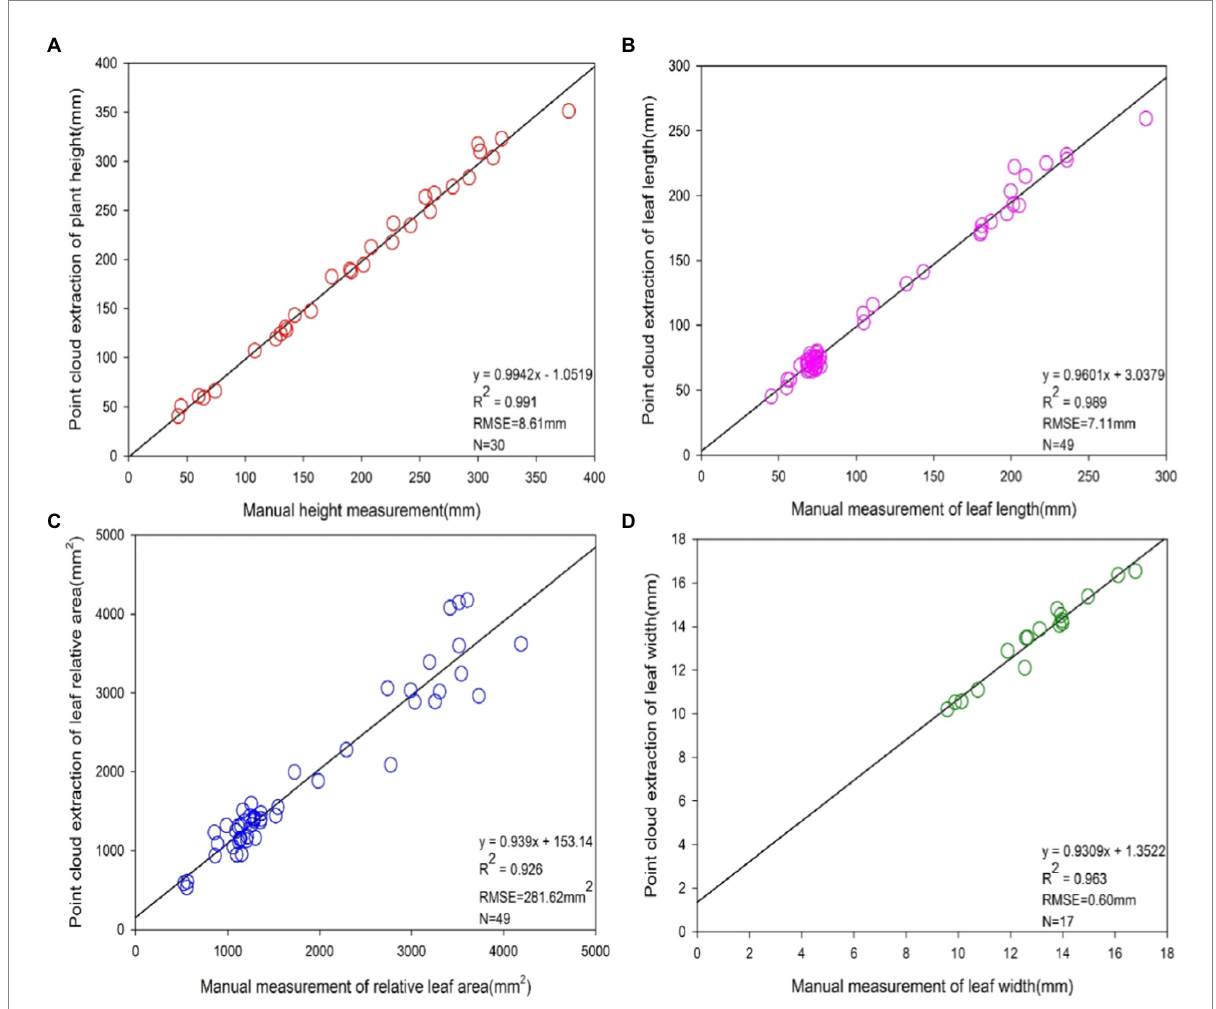
FIGURE 8 Accuracy analysis of phenotype extraction values based on 3D point cloud and manual measurements. From (A–D) , the precision analysis of phenotypes of plant height, leaf length, leaf relative area and leaf width based on 3D point clouds and manual measurements, respectively. The sample sizes N for four of the phenotypic indicators were 30, 49, 49 and 17,